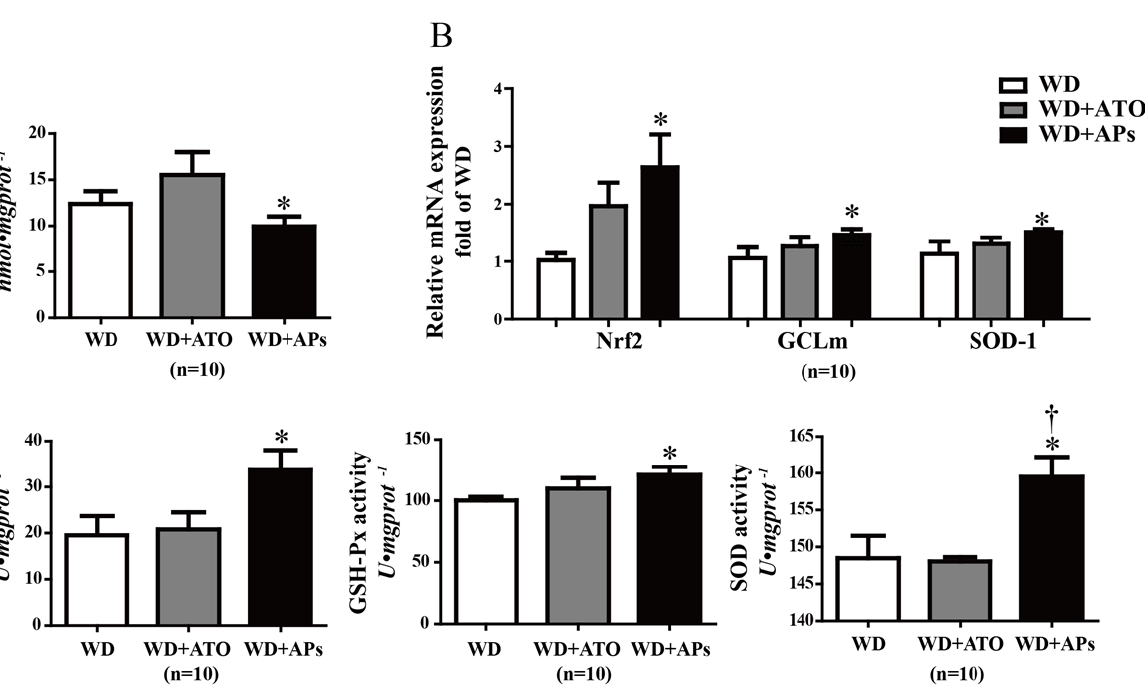
Figure 4. The APs attenuate hepatic oxidative stress in the WD-fed ApoE −/− mice. A : The hepatic concentration of MDA was measured by monitoring the formation of thiobarbituric acid-reactive substances; B : Expression of the antioxidant gene Nrf2 , GCLm and SOD-1 in the liver tissues of ApoE −/− mice fed with the WD or WD+APs (100 mg/kg/day) or WD+ATO (10 mg/kg/day) for 12 weeks; C : hepatic CAT, GSH-Px and superoxide dismutase (SOD) activities were measured in the liver tissues. The values are presented as the means ˘ S.E.M., n = 10 per group. * p < 0.05, ** p < 0.01, *** p < 0.001 vs. WD mice; : p < 0.05 vs. WD + ATO